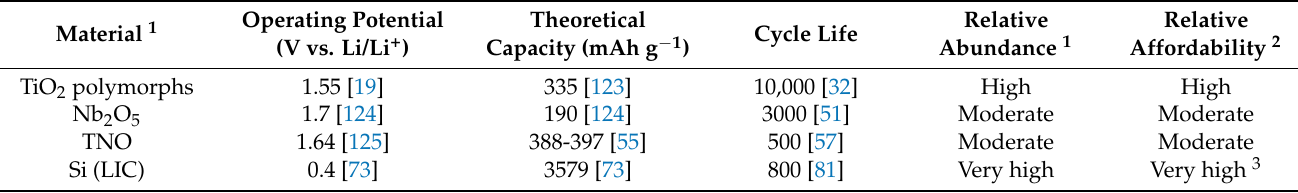
Table 1. Key performance indicators (KPIs) for the materials with the highest manufacturing potential for negative electrodes of LICs. Cycle life values are only examples as values in the field vary substantially and depend on many other factors. Material